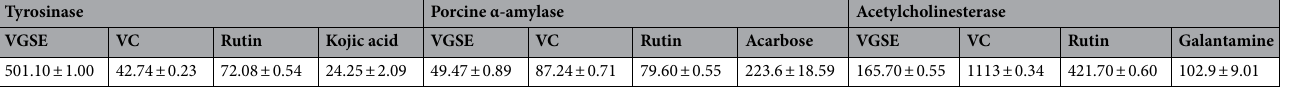
Table 3. In vitro enzyme inhibition activity. IC 50 (µg/mL) is the concentration of VGSE, antioxidant compounds, or standard compounds that can inhibit enzyme activity by 50%. Values are means ± SD of three experiments. Analysis was achieved using GraphPad Prism software (version